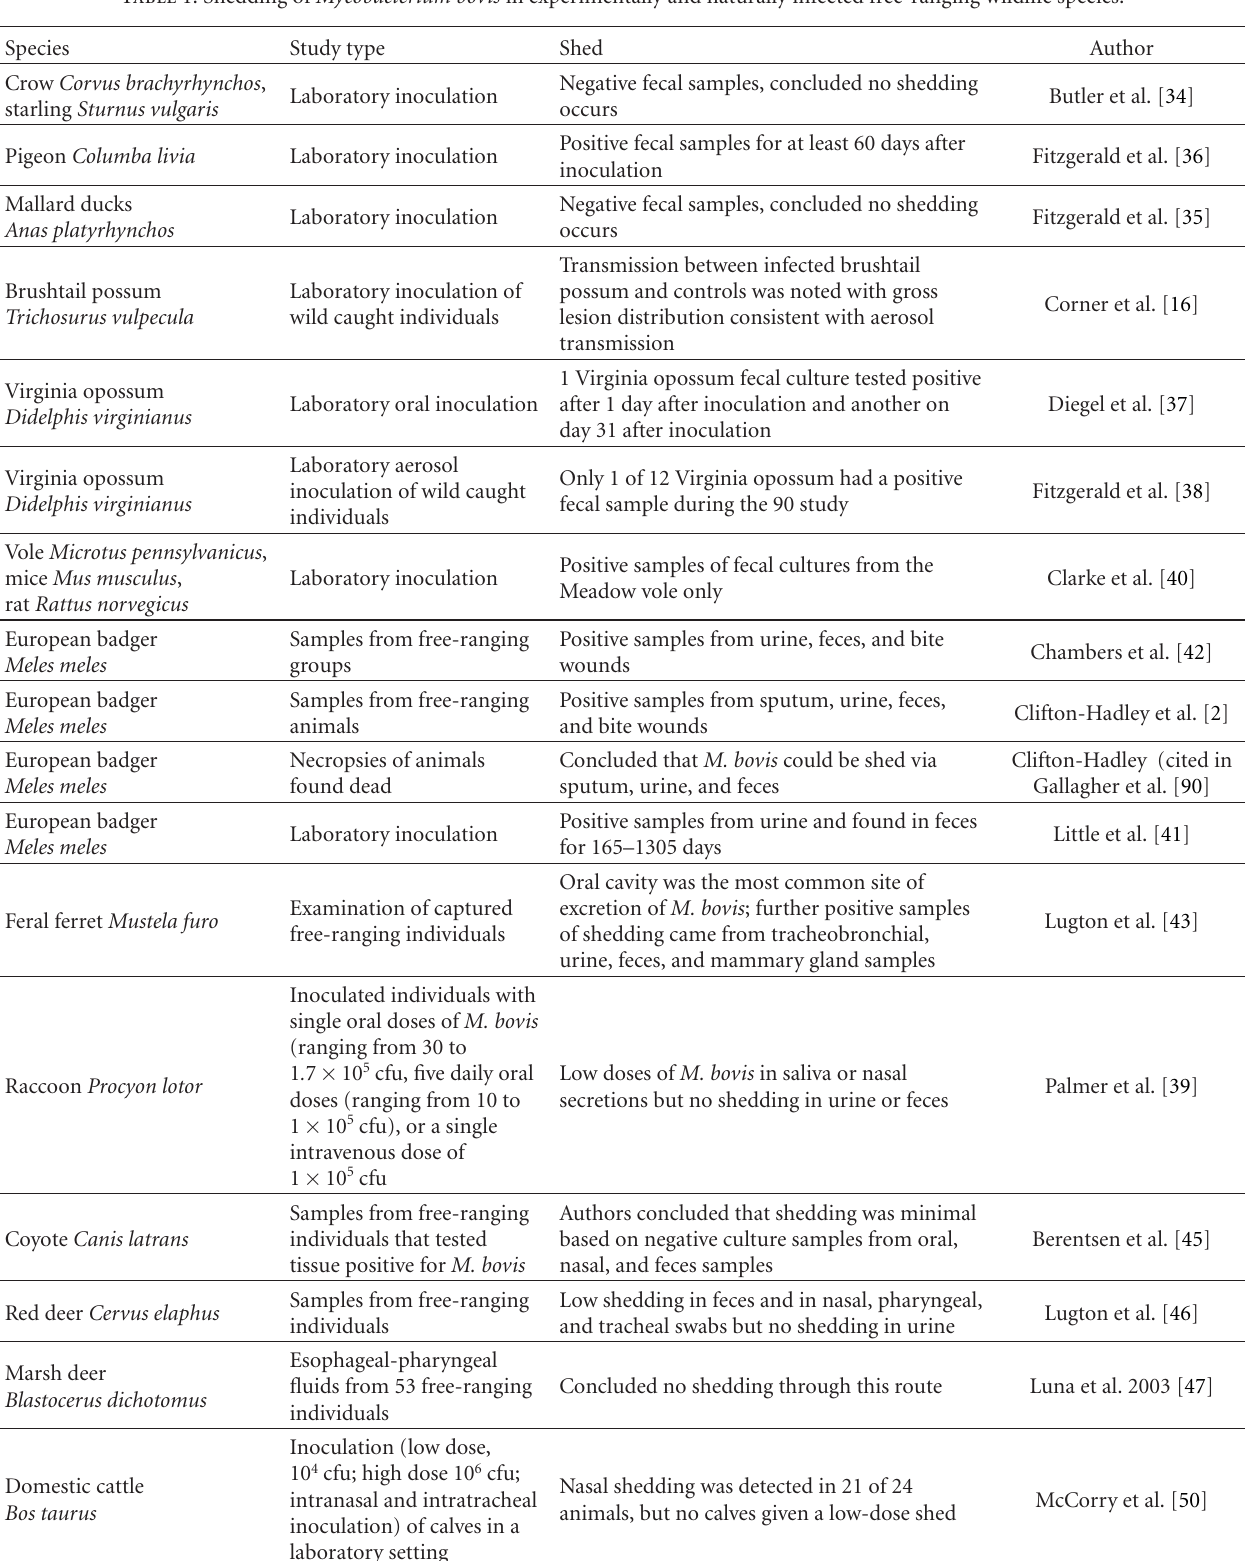
Table 1: Shedding of Mycobacterium bovis in experimentally and naturally infected free-ranging wildlife species.